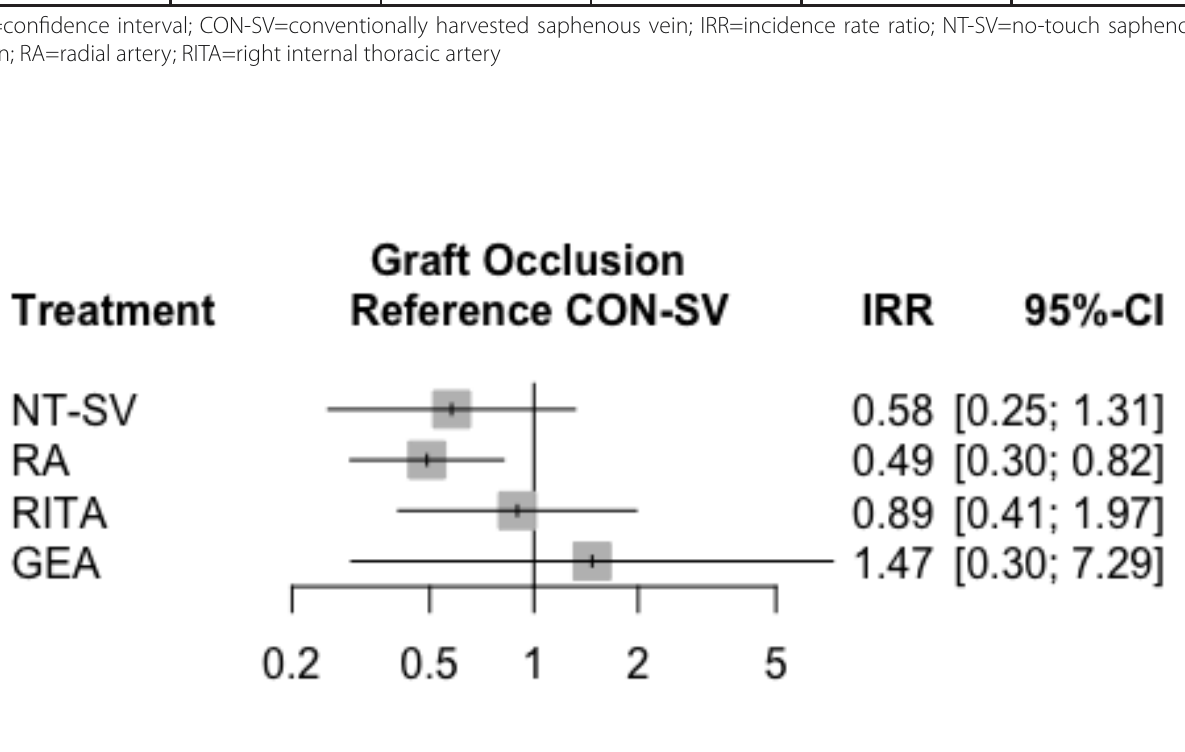
Fig. S3 - Subgroup analysis for the primary outcome in studies with target vessel stenosis ≥ 70%. CI=confidence interval; CON-SV=conventionally harvested saphenous vein; GEA=gastroepiploic artery; IRR=incidence rate ratio; NT-SV=no-touch saphenous vein; RA=radial artery; RITA=right internal thoracic artery.